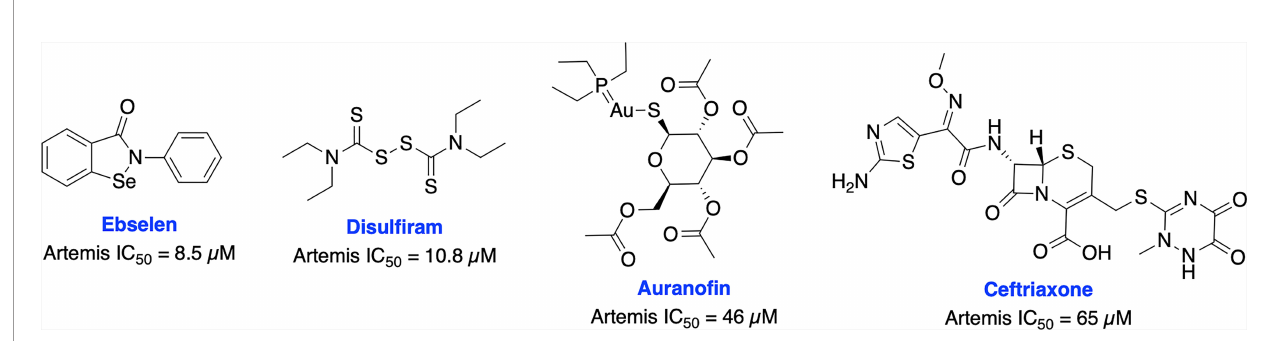
FIGURE 5 | Small molecule inhibitors targeting Artemis and their respective IC50 values for disruption of endonuclease